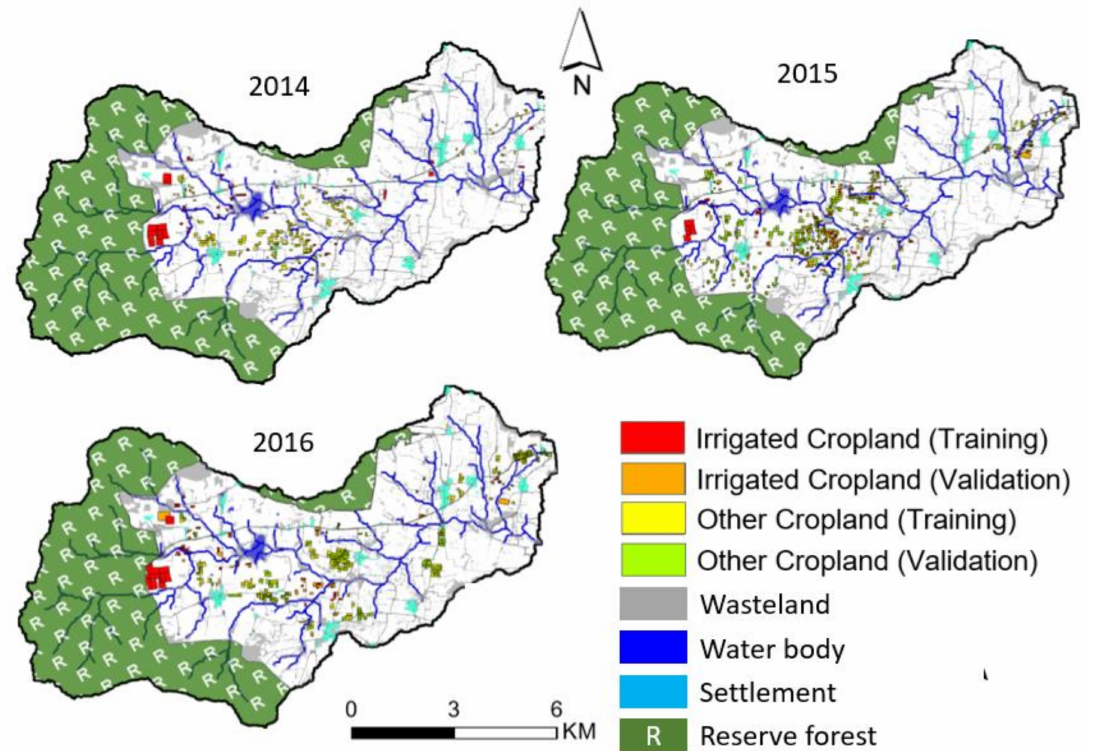
Figure 3. Ground-observed training (calibration) and validation fields with annual (summer + kharif + rabi) irrigated (intensive irrigation) and other (partial irrigation in the absence of rainfall, rainfed only, and fallow land) croplands for 2014, 2015, and